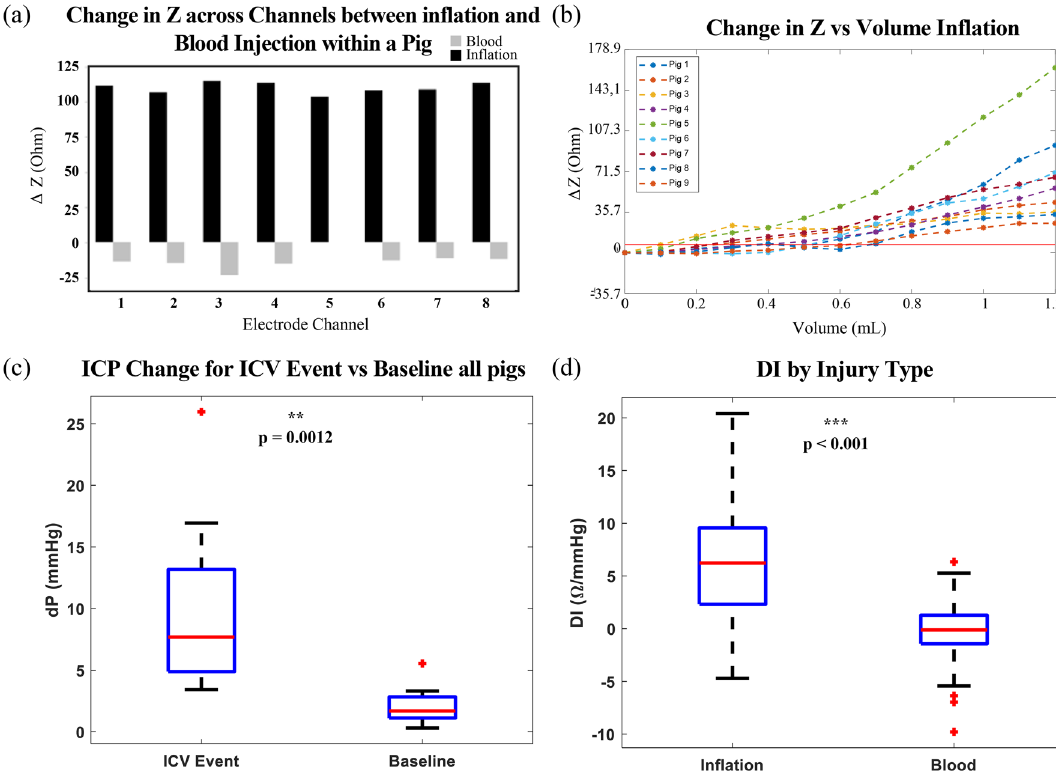
Figure 5. Identification and differentiation of secondary brain injury. ( a ) ΔZ compared between injury types across all channels within a single pig. Missing channel (5, blood) is a filtered trace. ( b ) Change in impedance from baseline of de-trended volume balloon inflation. Threshold for detection determined from SNR with a 10 × safety factor (7.1 Ω) and represented by the horizontal red line. Impedance successfully detected ICV change in all nine pigs. ( c ) Change in ICP successfully differentiates a volumetric event from baseline, however cannot discriminate between injury type (Supplementary Figure 8). ( d ) Discriminatory Index significantly differentiates the type of event (injury)